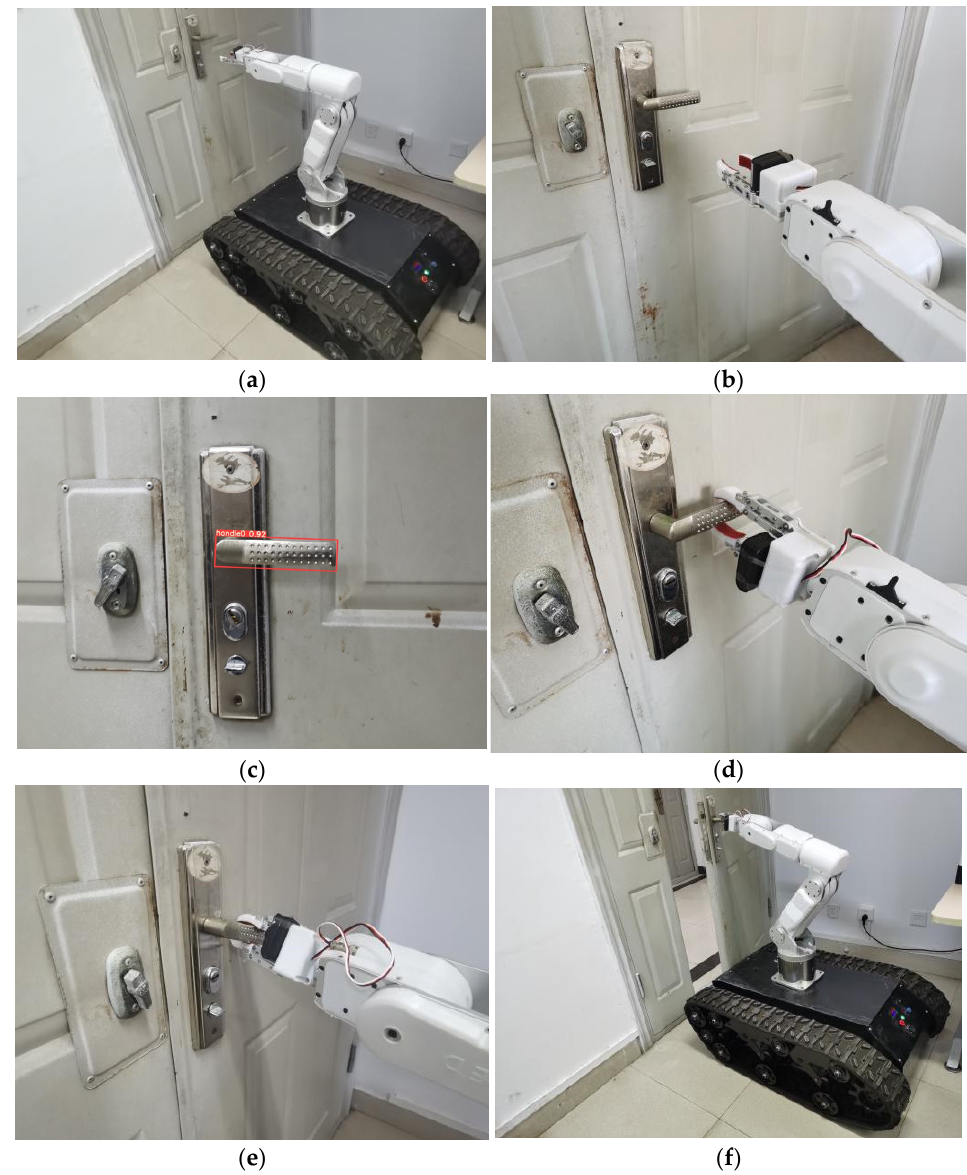
Figure 16. The effect of the simulation experiment. ( a ) The platform moving to the operation area. ( b ) Adjusting the position. ( c ) Image recognition. ( d ) The grasping operation. ( e ) Revolving door handle. ( f ) The door-opening operation.